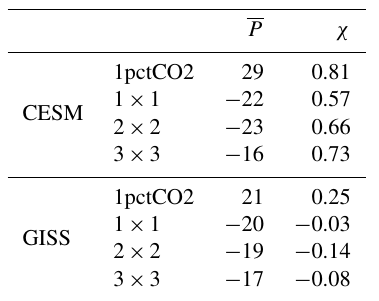
Table 3. Residual changes in global mean precipitation ( P ) and the precipitation centroid ( χ ; Eq. 1) for all of the simulations in the 3 × 3 design case. Changes are compared to the preindustrial control simulation. Units for P are in mmyr − 1 , and units for χ are in degrees latitude. Reported values are averages over years 61–70 of